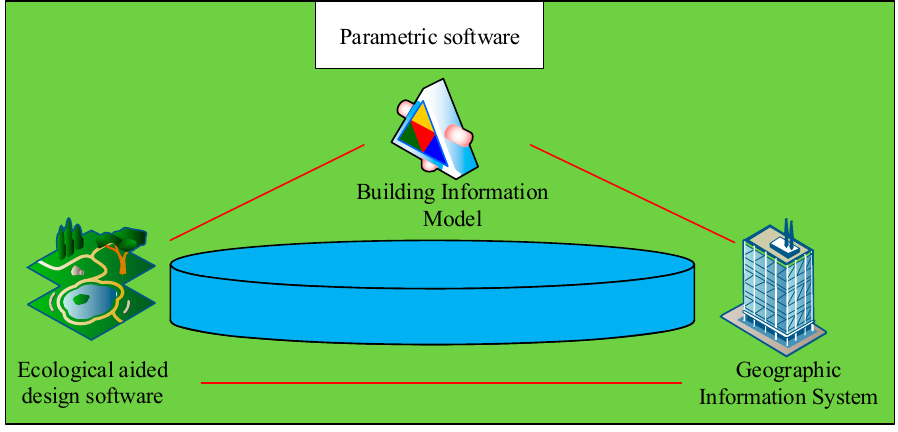
Figure 1. Software with large parameterization impacts.